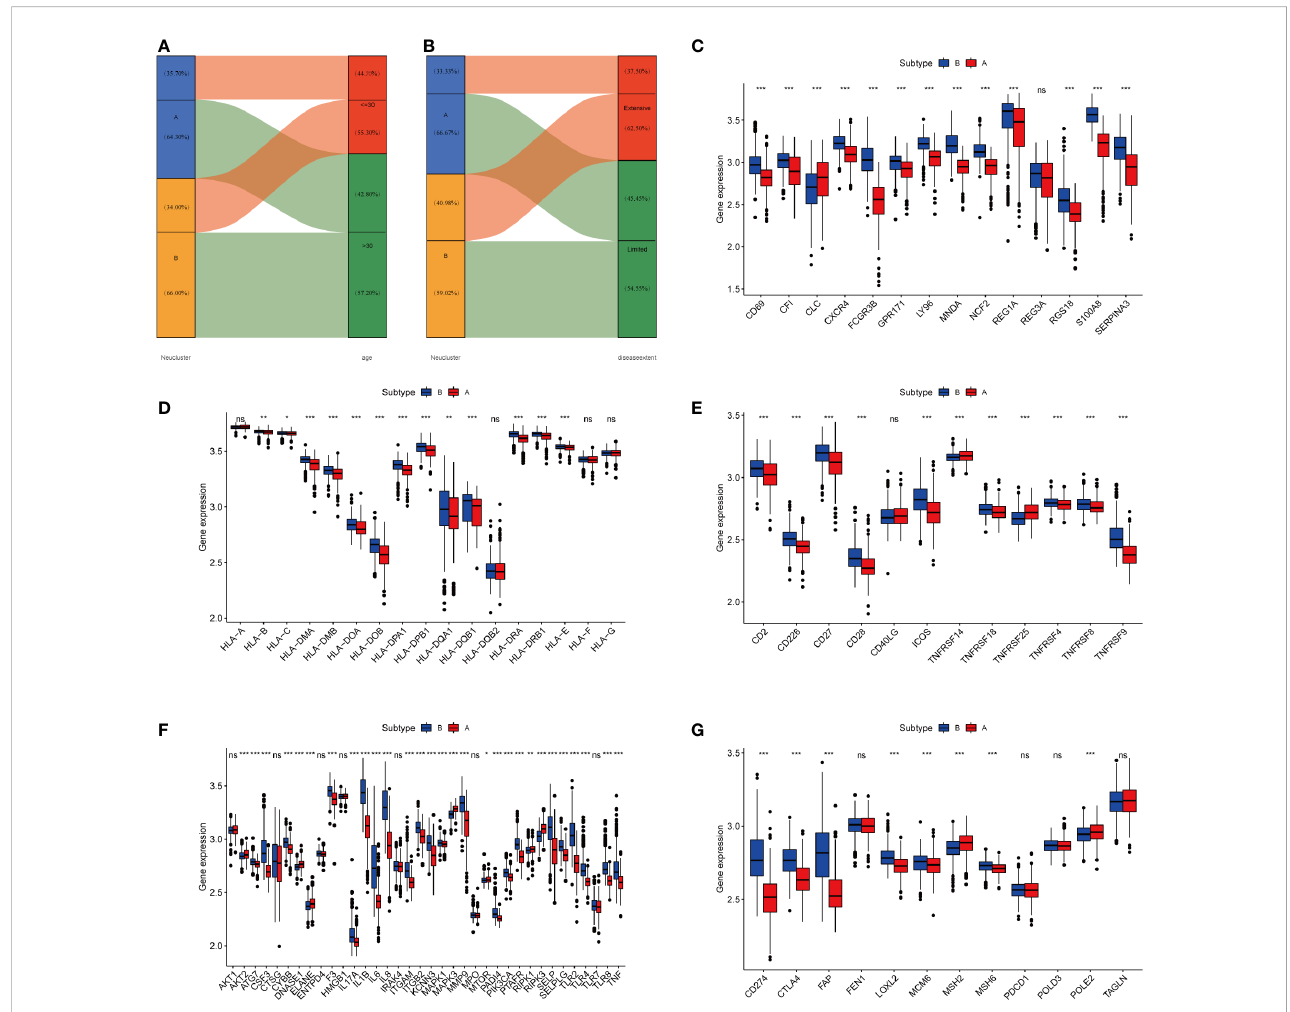
FIGURE 4 High-in fi ltration neutrophils of subtype B were more likely to develop CAC. (A, B) Alluvial diagram of subtype distributions in groups with different clinical features. (C) Gene expression of CAC-related gene between two distinct clusters. (D, E) Gene expression of HLA and MHC gene sets between two distinct clusters. (F) Gene expression of NETs-related gene sets between two distinct clusters. (G) Expression of immune checkpoints between two different clusters. The asterisks represented the statistical P-value (ns, not signi fi cant; P > 0.05; *P < 0.05; **P < 0.01; ***P <